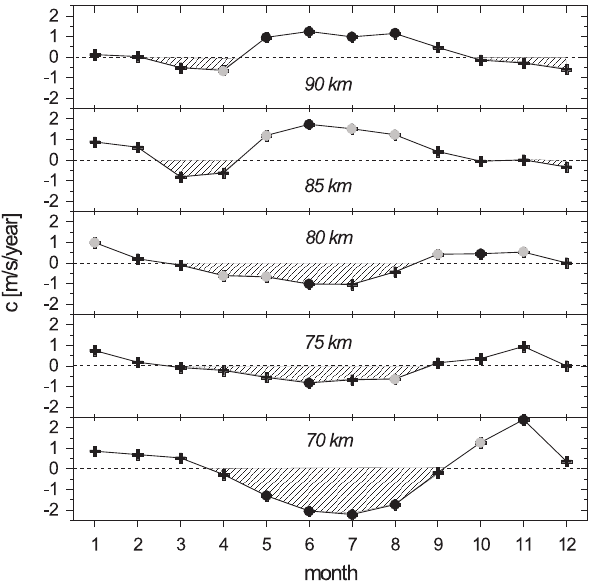
Fig. 13. Seasonal variation of the trend in the mesospheric zonal wind at Juliusruh (partial regression coefficient c due to Eq. 1) for different heights. The significance levels χ are marked by black dots ( χ ≥ 95%), grey dots ( χ ≥ 90%), and crosses ( χ< 90%).